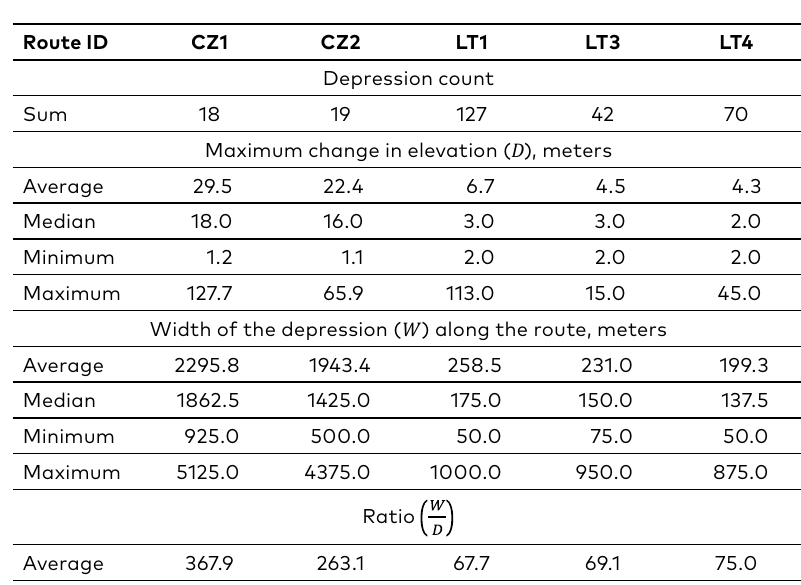
Table 1. General statistics of altitude